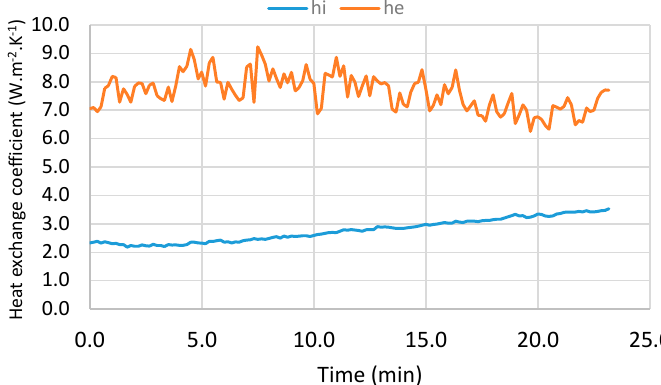
Appl. Sci. 2021 , 11 , x FOR PEER REVIEW Figure 12. Internal ( hi ) and external ( he ) surface heat exchange coefficients.